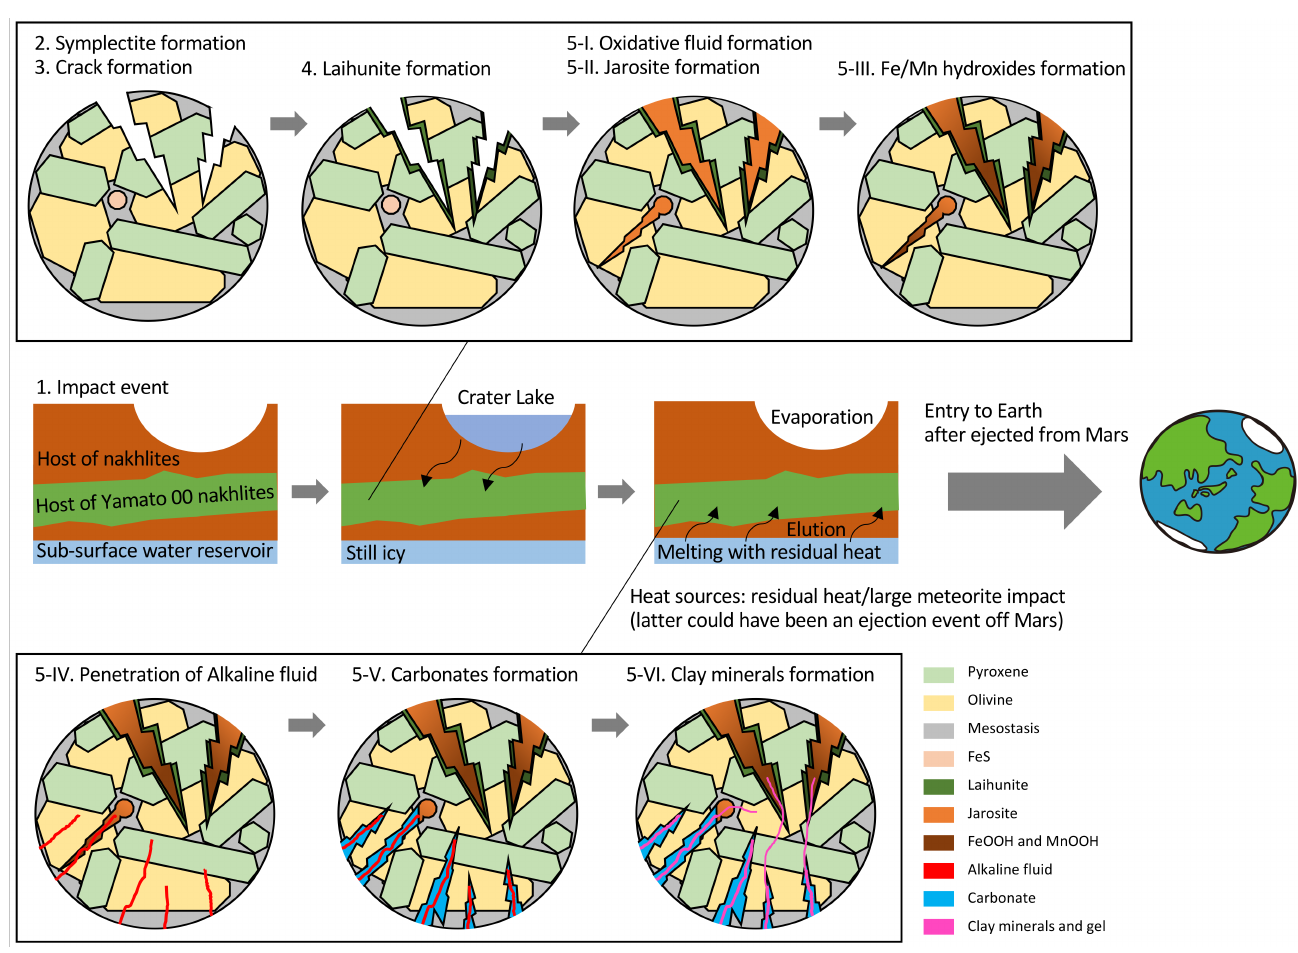
Figure 10. Ejection from Mars and journey to